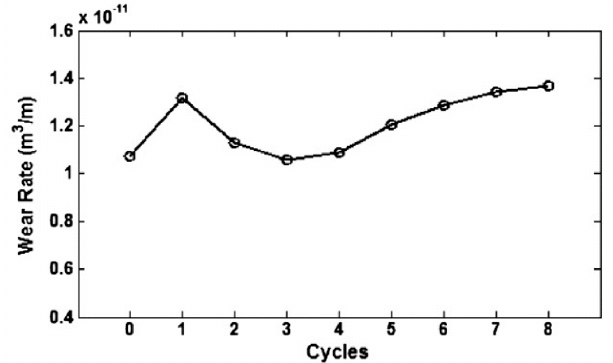
Figure 19. Variation of wear rate versus number of ARB cycles [125].